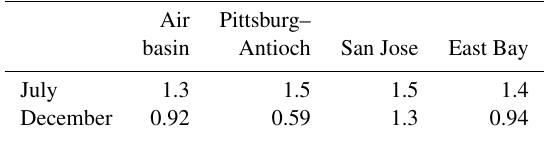
Table 1. Model responses in parts per billion. Model responses are population-weighted monthly average formaldehyde mixing ratios for the San Francisco Bay Area (air basin) and selected